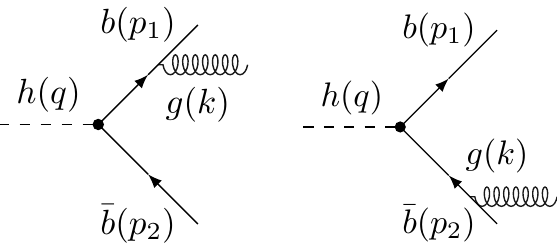
Figure 1 . Real-emission contributions to the decay of the Higgs boson into a b ¯ b pair at O ( α s ) . For the calculation in the massive scheme we keep p 2